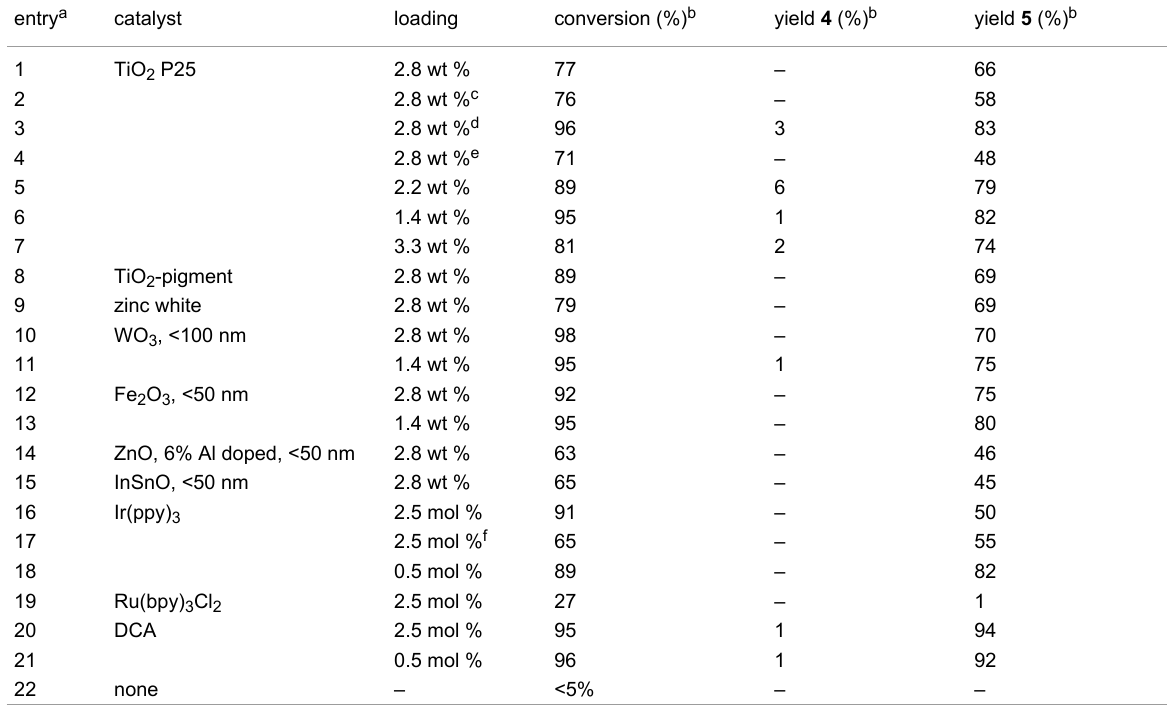
Table 4: Heterogeneous sensitizer variation for model reaction in comparison with optimized homogeneous conditions for model process. entry a